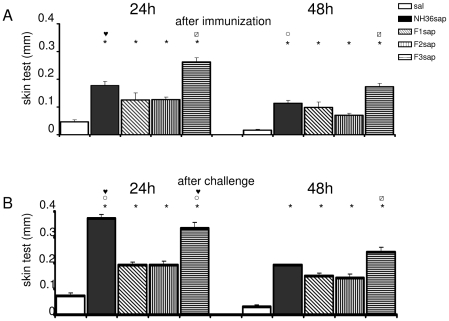
Intradermal response to the leishmanial antigen.(A) 24 h and 48 h after complete immunization and (B) after challenge with 3×107 amastigotes of L. chagasi obtained from hamster spleens. Results of 3 independent experiments with 20–24 mice per treatment (A) and 8–11 mice (B) per vaccine group are shown as mean + SE. * p<0.05 significantly different from the saline treated controls,  the F1, ○ the F2 or  from all the other vaccines.